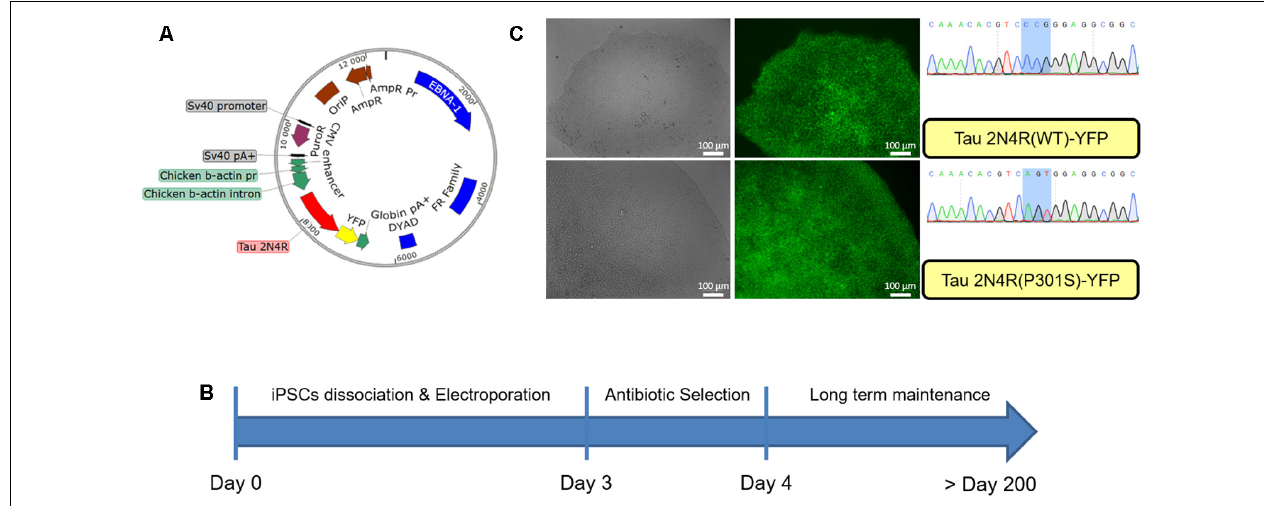
FIGURE 1 | Generation of modified induced pluripotent stem cells (iPSCs) using an epstein-barr virus (EBV)-based plasmid. (A) Map of the EBV-based plasmid used in iPSCs, transgene expression under CAG promoter regulation, puromycin resistance under SV40 promoter regulation. (B) Workflow for EBV-based plasmid expressing iPSCs generation. (C) iPSCs colony after 30 passages post-electroporation expressing either wild type Tau 2N4R or mutated (P301S) form fused to